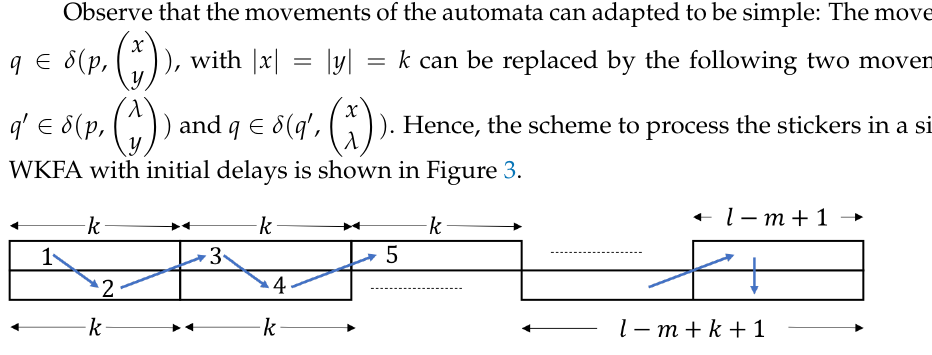
Figure 2. Stickers organization to be processed with initial delays.